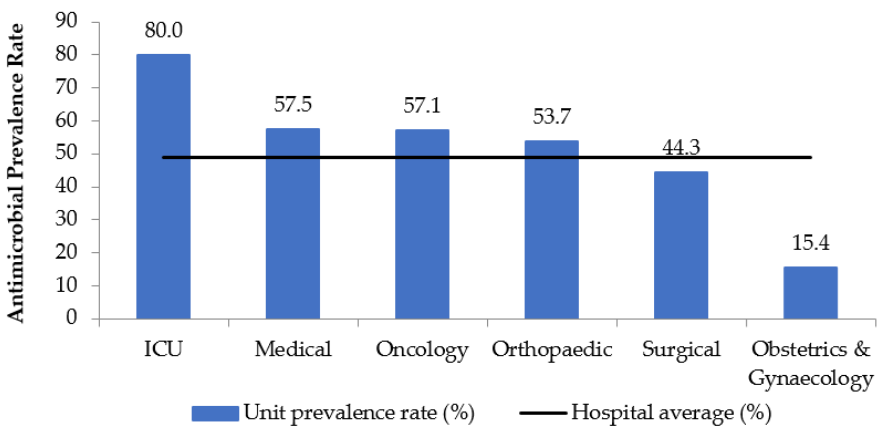
Figure 1. Antimicrobial prescription rates in various units.